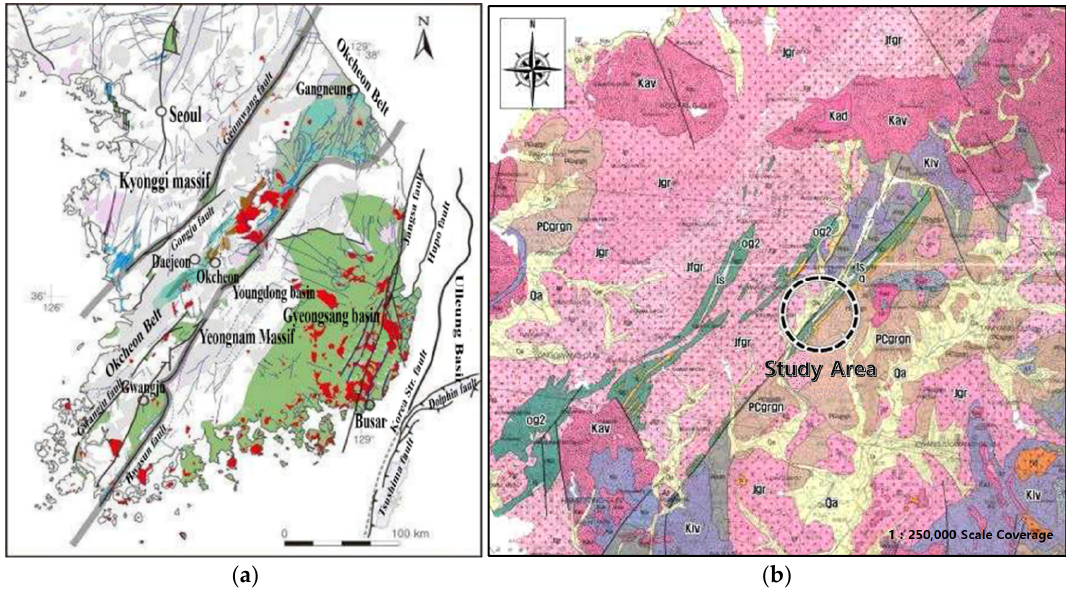
Figure 7. Regional structural and geological maps of the study area, ( a ) regional structural and tectonic map, ( b ) regional geological map of area.